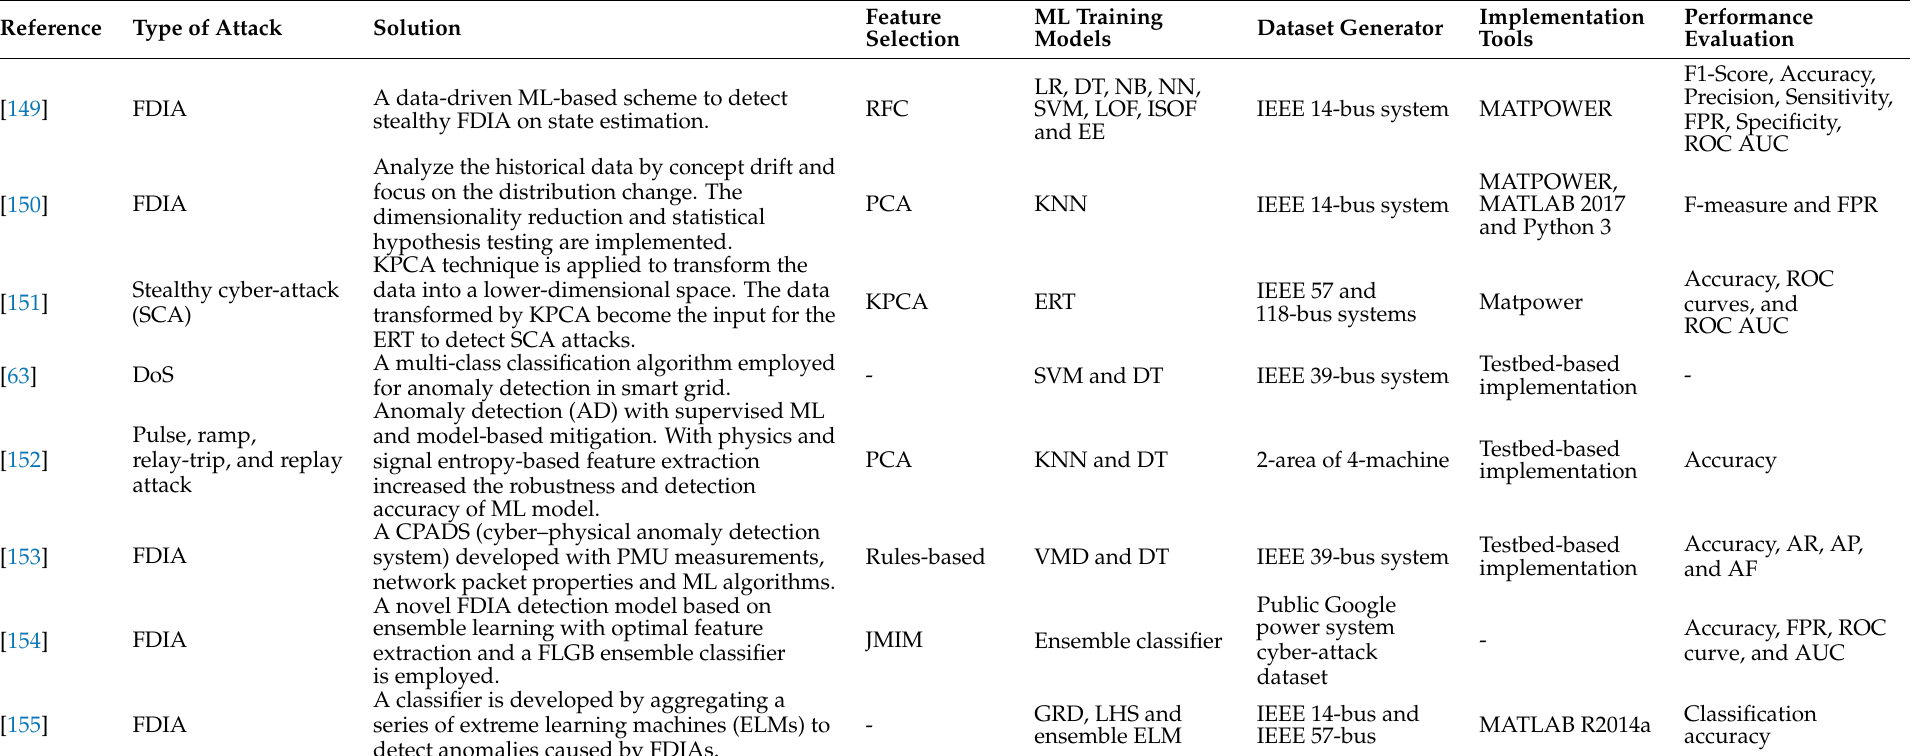
Table 12. Machine learning based attack detection techniques for cybersecurity in smart